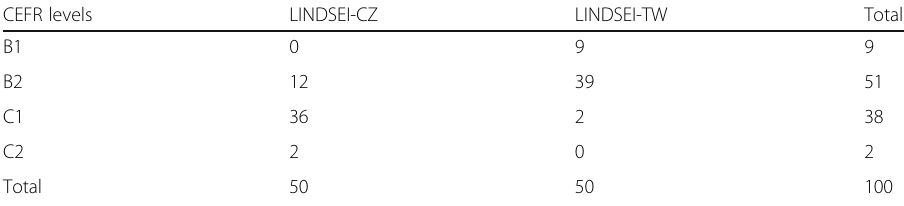
Table 6 The distribution of learners ’ speaking proficiency on the CEFR scales CEFR